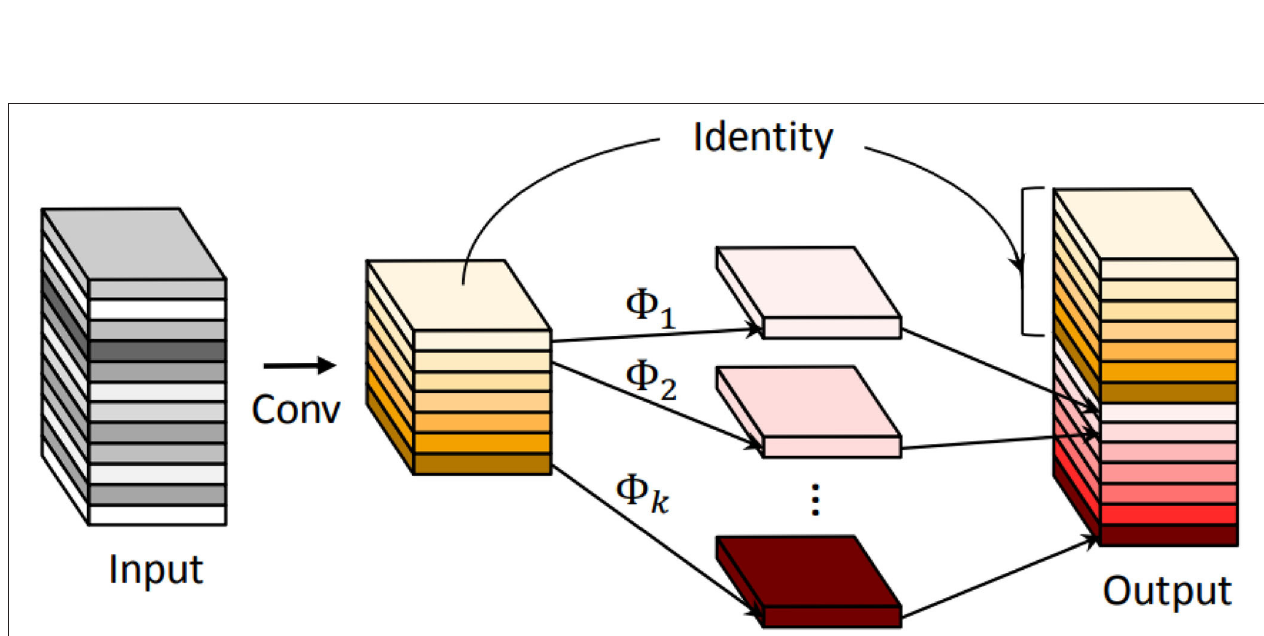
FIGURE 4 | An illustration of the convolutional layer and the introduced Ghost module for outputting the same number of feature maps. 8 represents the cheap operation.